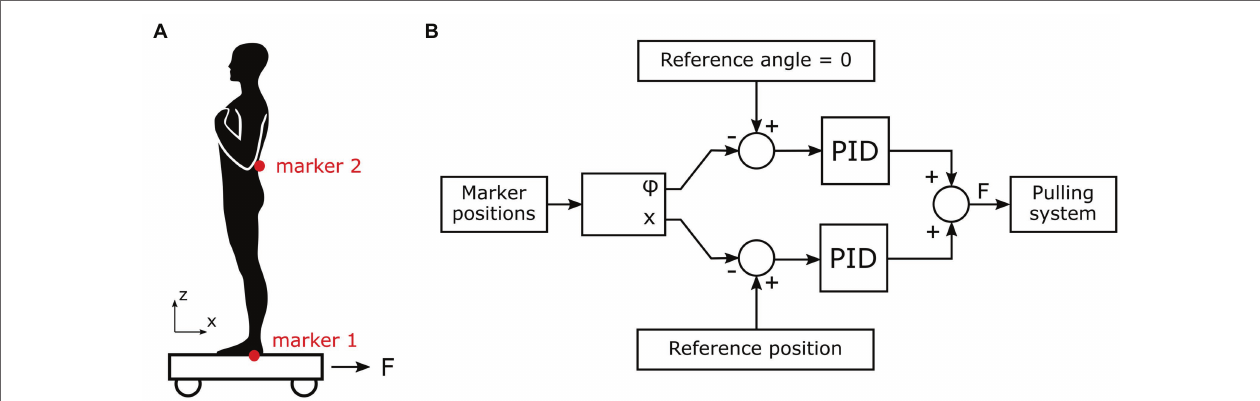
FIGURE 1 | (A) Human participant standing on the cart and the location of the motion capture markers. Marker 1 is placed on the cart below the ankle joint and marker 2 is placed on the L5 vertebra as an approximation of the center of mass (COM) position. (B) Scheme of cart controller to stabilize the participant’s COM. φ is the angle between vertical line and the line that connects both markers, x is the horizontal position of marker 1, and F is the resulting force applied on the